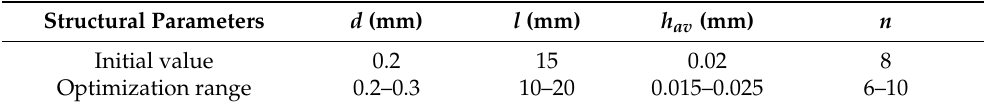
Table 2. Optimization range of structural parameters.